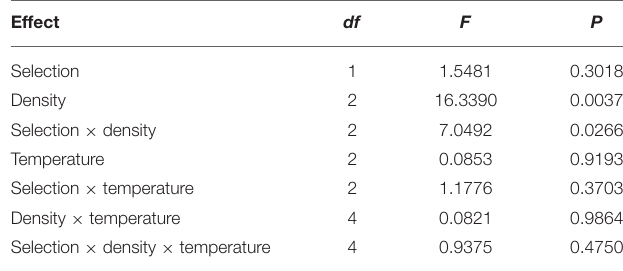
TABLE 6 | Results of ANOVA for standard deviation of survivorship across vials. TABLE 7 | Results of ANOVA for CV of survivorship across